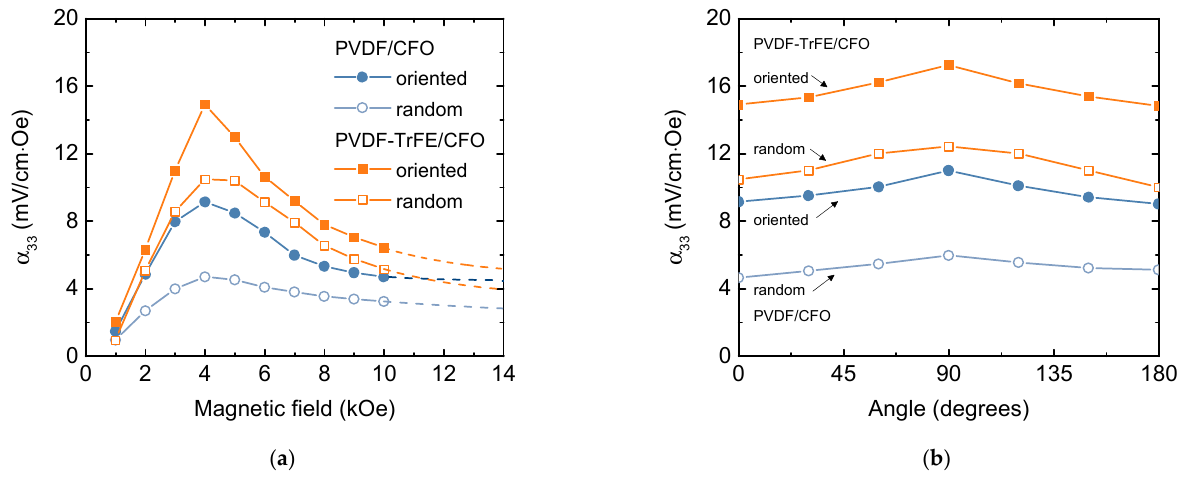
Figure 7. ( a ) Field and ( b ) angular dependencies of the ME voltage coefficient ( α ME ) on DC bias magnetic field for ordered and random PVDF/CFO and PVDFTrFE/CFO composites at AC field frequency of 10 kHz.